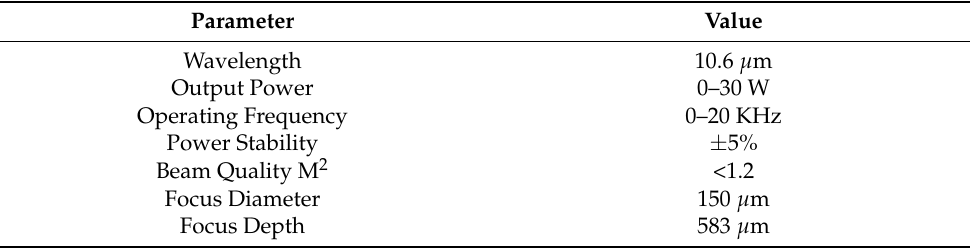
Figure 2. The architecture of the 6-axis 5-linkage laser engraving experimental platform. Table 2. Parameters of the laser beam.